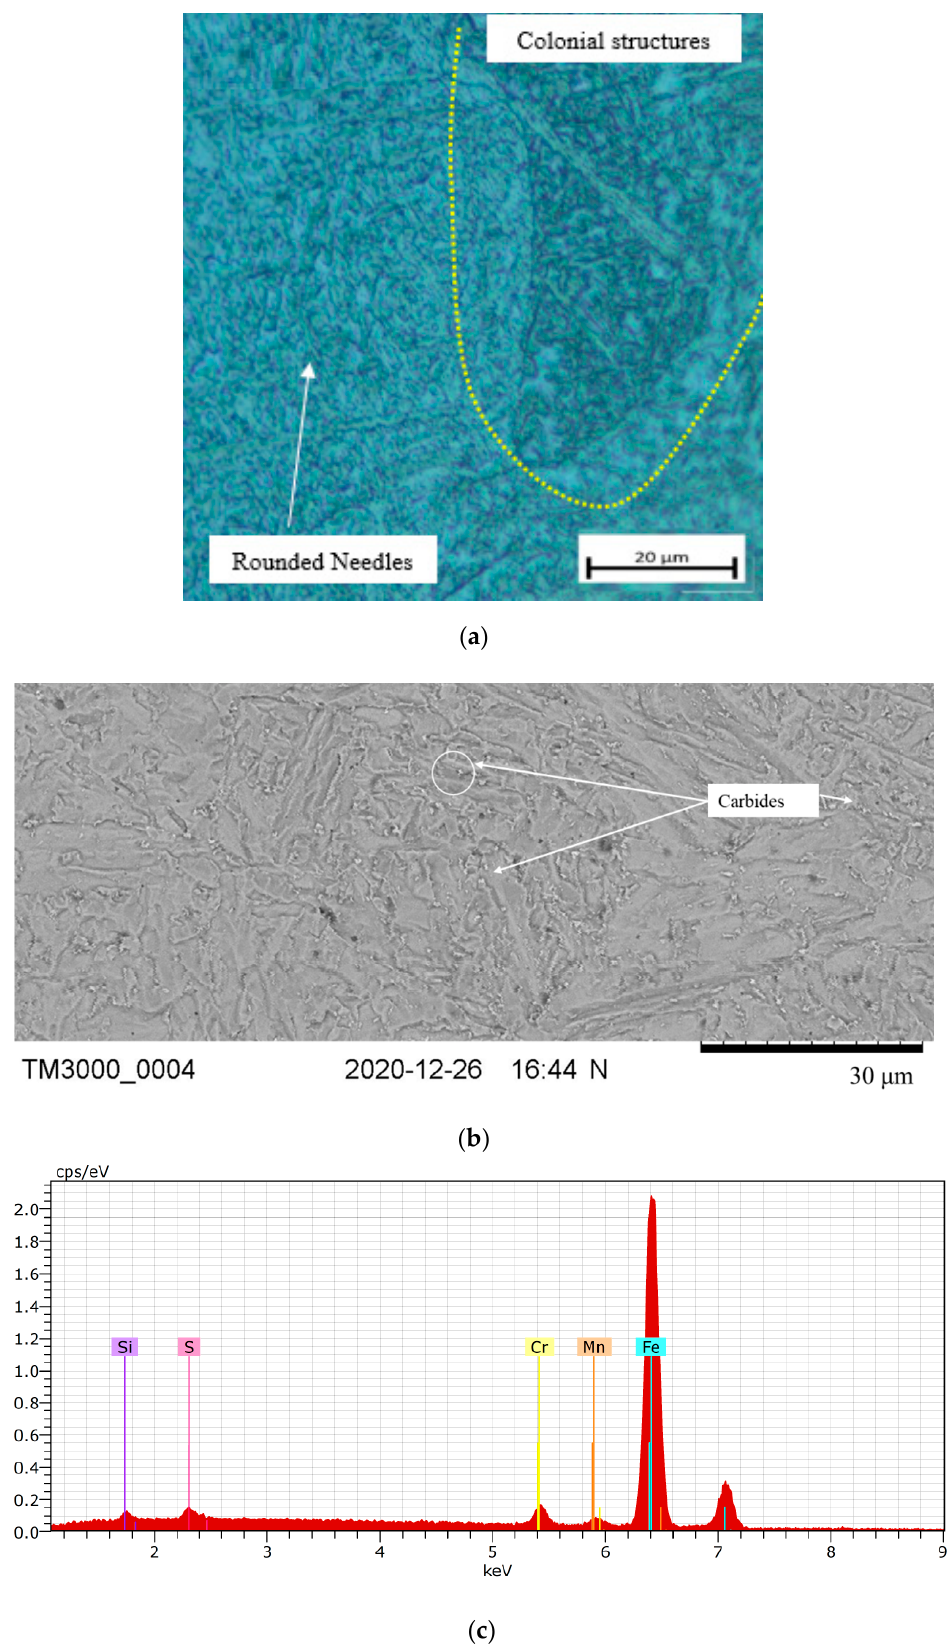
Figure 8. Microstructure analysis of the weld zone subjected to SCHT. ( a ) Optical microscopy, ( b ) SEM image, and ( c ) EDX analysis.